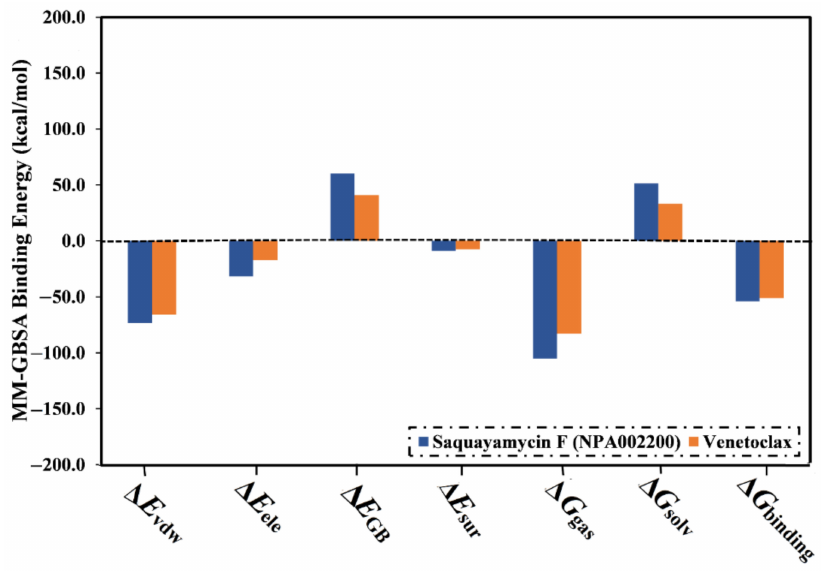
Figure 4. Binding energy components for venetoclax and the saquayamycin F (NPA002200) com- plexed with the Bcl-2 protein during the 200 ns MD simulations.